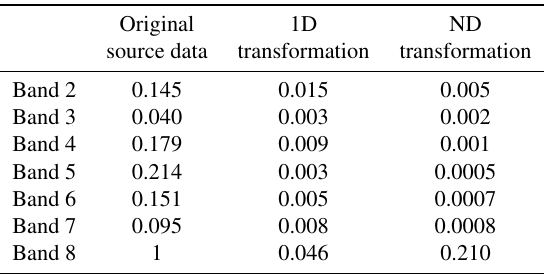
Table 1: Kolmogorov-Smirnov